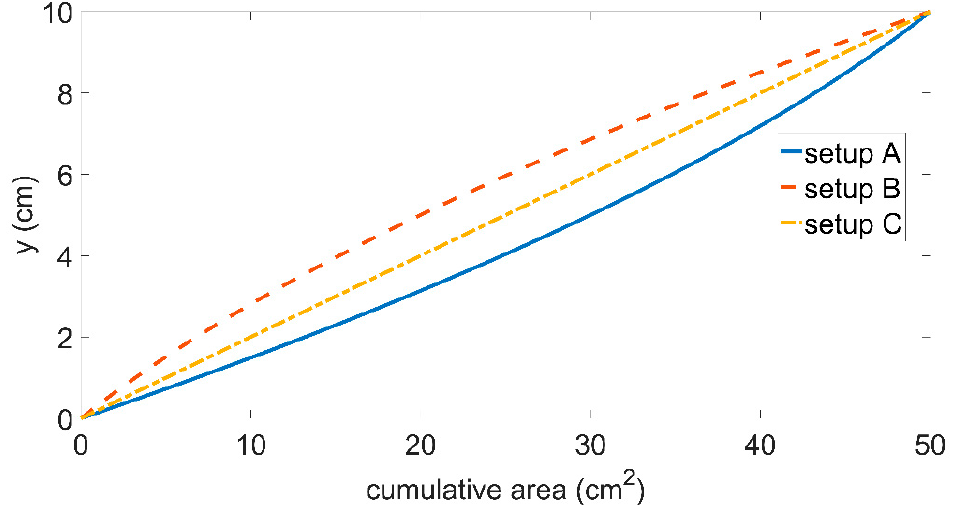
Figure 2. The cumulative area of vegetation models vs. vegetation height.